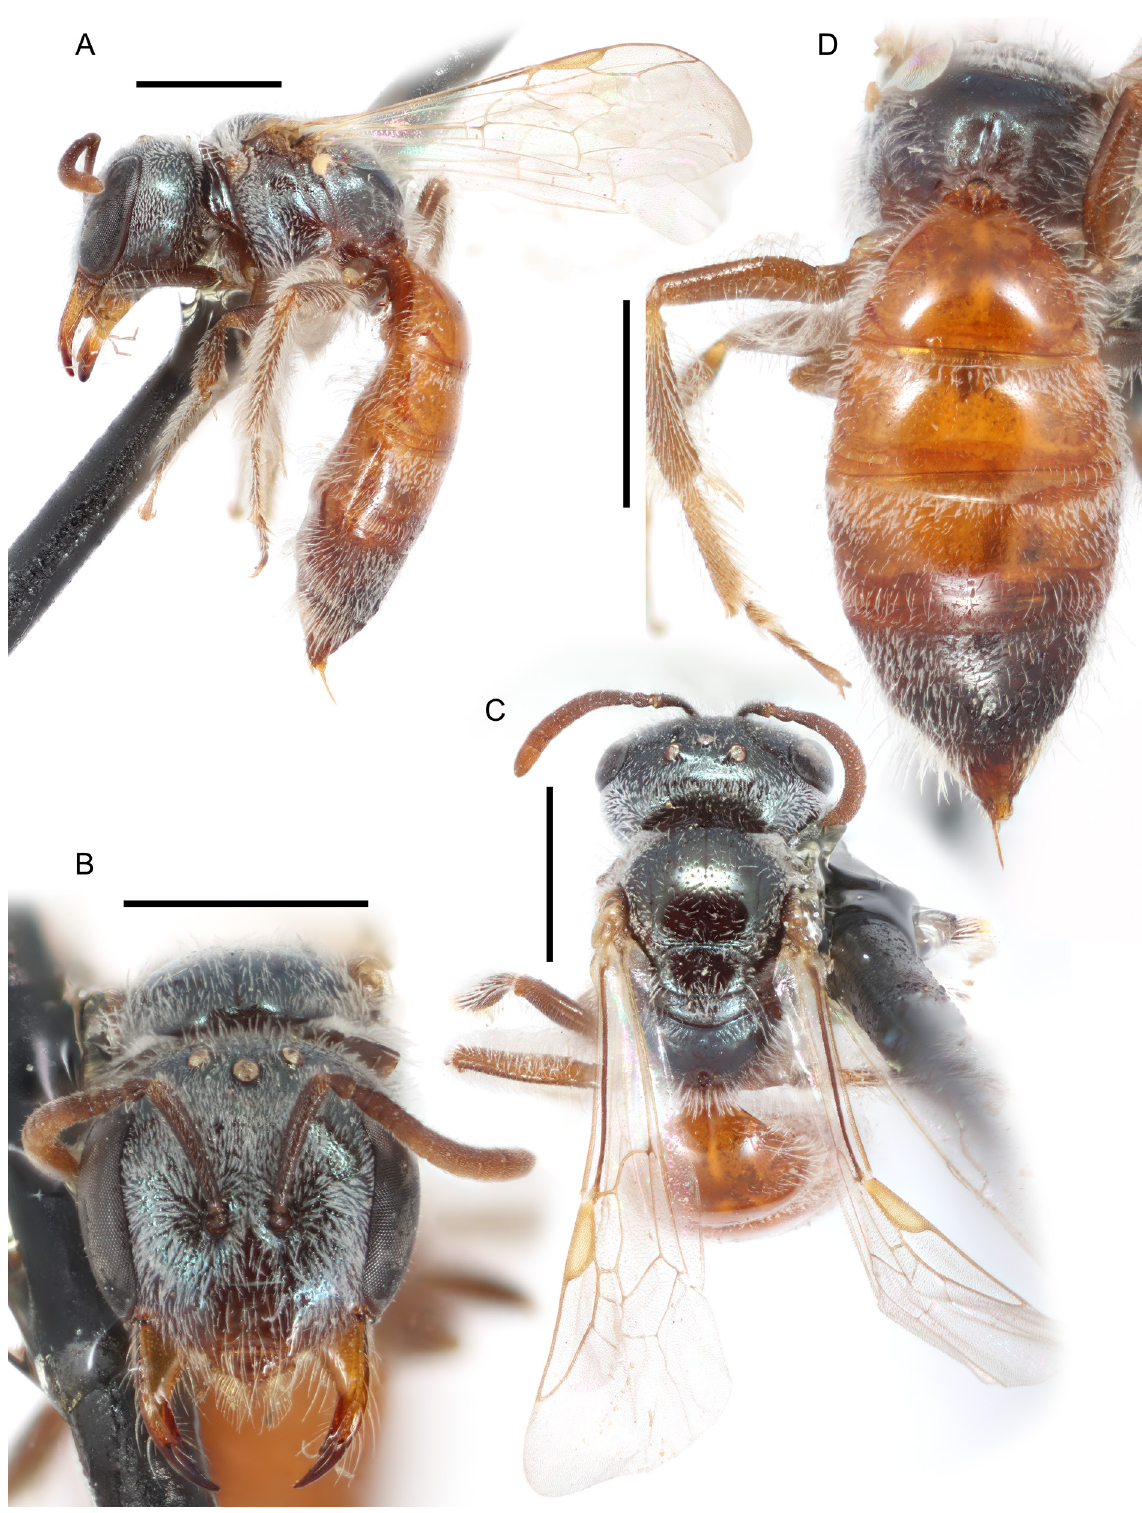
Fig. 49. Lasioglossum ( D. ) kunzei (Cockerell, 1898), ♀. A . Lateral habitus. B . Face. C . Dorsal habitus. D . Propodeum and metasoma. Scale bars: 1